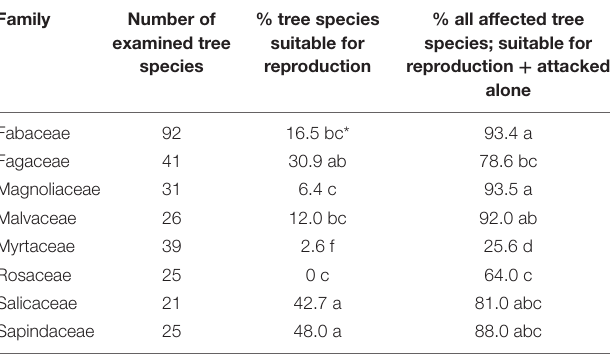
*Means sharing the same letter do not significantly differ (probability of χ 2, n = 1). Normal approximations used for ratio confidence limits effects: Tests and confidence intervals on odds ratios are Wald